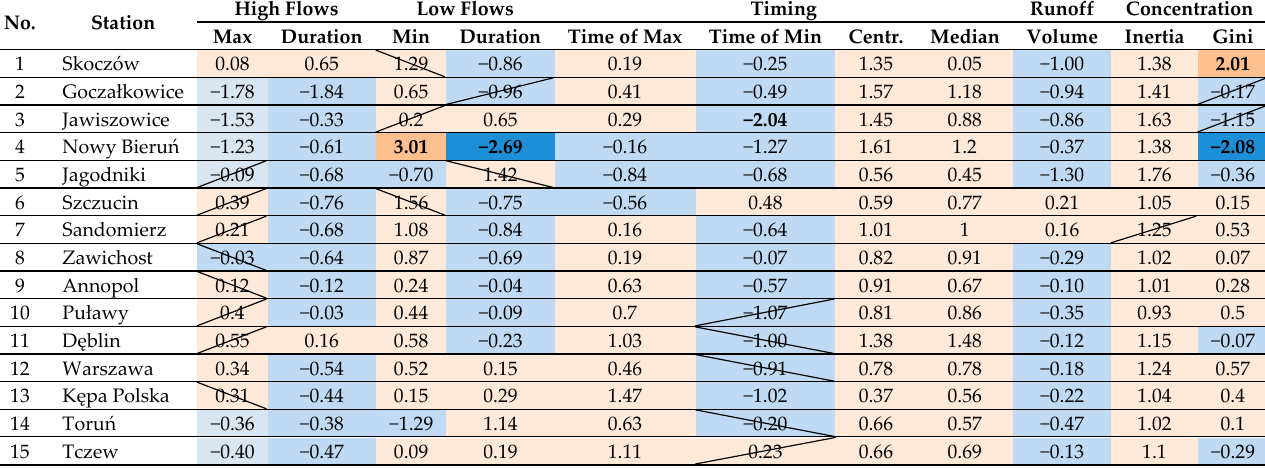
Table 6. Results of the Mann test ( uF statistics) for trends in the summer season daily flow characteristics along the Vistula course; orange colour denotes positive uF values, blue colour negative. The marks represent the diagonal lines from the upper left corner to the lower right to show that the value can decrease if autocorrelation is taken into account and opposite is true for the cases when the autocorrelation causes an increase in the presented value. Numbers in bold indicate statistically significant changes at α level 0.05.